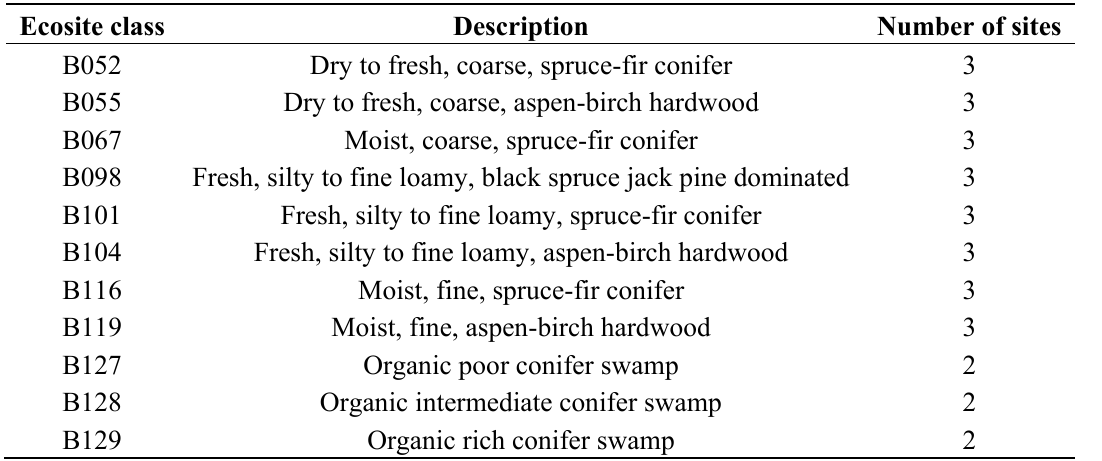
Table 1. Ecosite classes and